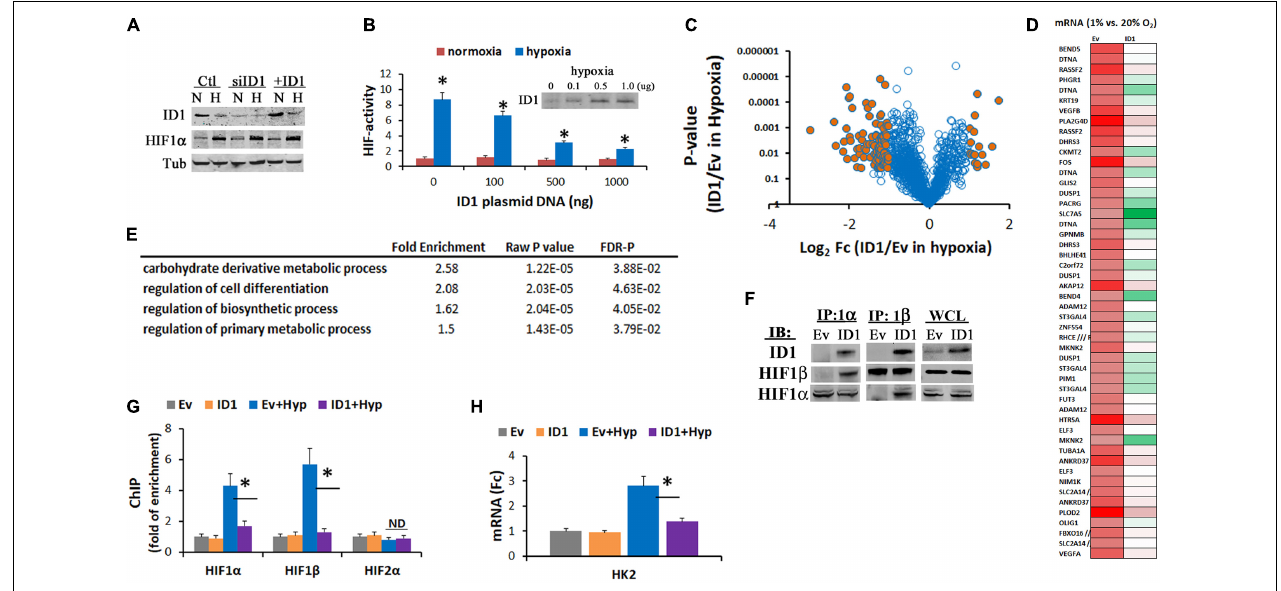
FIGURE 5 | (A) Western blots of ID1, HIF1 α , and tubulin (control) in Hep3B cells with siNT/siID1 or Ev/ID1-overexpression in 20% or 1% O2. (B) Hep3B-c1 cells that stably transfected with HIF-reporter system (hypoxia/HIF-driving firefly luciferase with constitutive renilla luciferase as control) were transfected with increasing amounts of ID1-overexpressing plasmids, and cultured in 20% or 1% O 2 for 24 h. HIF-activity was determined by dual-luciferase measurements as described before (Zhang et al., 2008). ∗ P < 0.05, ANOVA, mean and stdv, n = 3. Inserts: ID1 western blots. (C) LNCaP-Ev and LNCaP-ID1 cells were cultured in 20% and 1% O2 for 24 h, and then underwent Affymetrix cDNA microarray. Volcano plot of hypoxia-response genes in LNCaP-ID1 vs. LNCaP-Ev cells. (D) Heatmap of hypoxia-upregulated genes in Ev-cells, which were attenuated in ID1-cells, color: green → red = gene expressions low → high. (E) GO pathway analysis of hypoxia-upregulated genes that were attenuated by ID1. (F) Ev or ID1 cells were cultured in 1% O 2 for 24 h. Whole cell lysates (WCL) were immunoprecipitated with antibodies for HIF1 α , and probed for ID1, HIF1 α , by western blots. (G,H) LNCaP-Ev or -ID1 cells were cultured in 20% or 1% O2 for 24 h. The enrichments of HIF1 α , HIF1 β , or HIF2 α (relative to IgG control) at HK2 gene promoter were determined by ChIP (G) . The levels of HK2 gene expression were determined by qRT-PCR (H) . ∗ P < 0.05, t -test, mean and stdv, n =